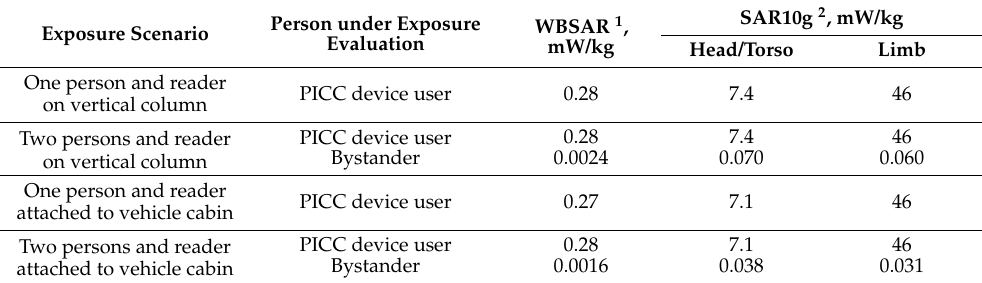
Table 3. SAR values in the human body models in various exposure scenarios related to exposure to EMF at 13.56 MHz near to the HF RFID reader with an internal antenna with inner dimensions of 8 × 8 cm, assuming that the RR of considered reader is 10 cm (according to ISO/IEC 14443-2:2020 requirements for PICCs of classes 1–3).